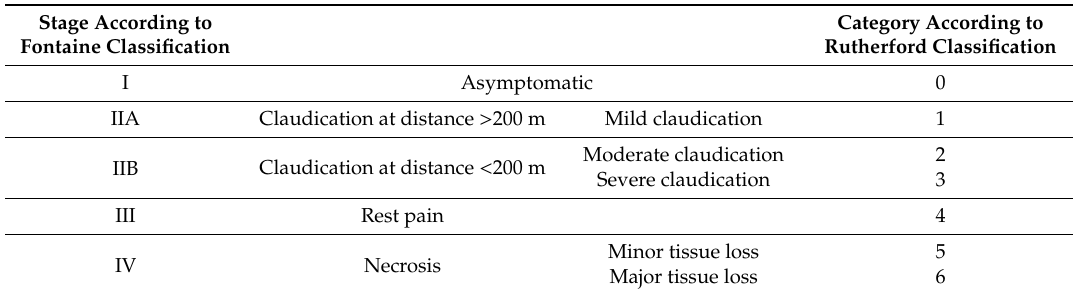
Table 1. Classification of claudication severity according to Fontaine and Rutherford scales